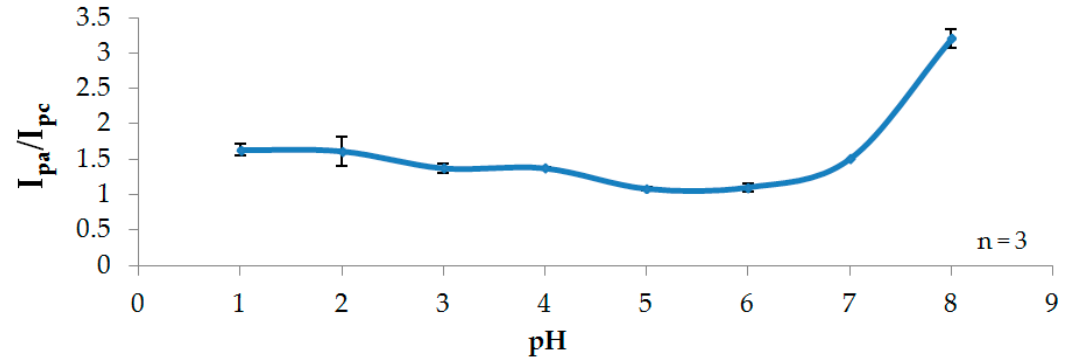
Figure 6. Product stability as a function of pH. Not visible error bars: when the symbol size is larger than the error bar.